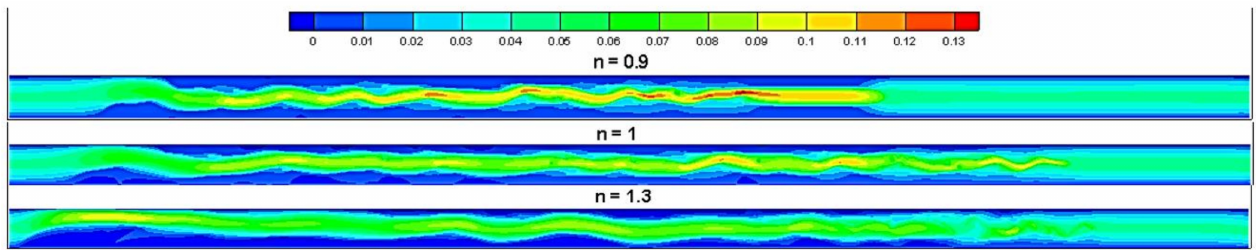
Figure 7. The apparent shape of the finger structure for different n.